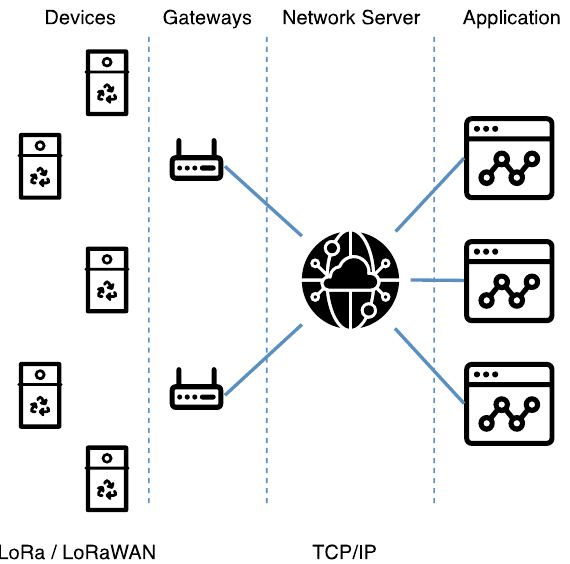
Figure 1. LoRaWAN architecture.